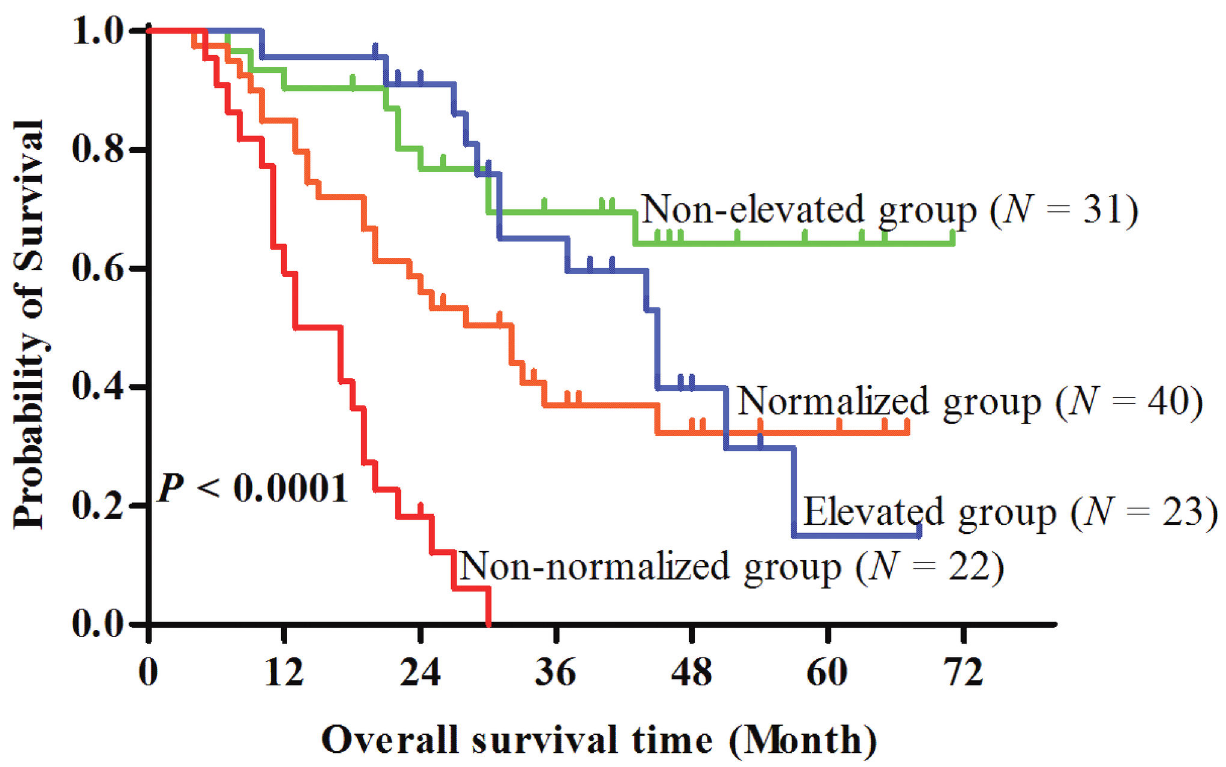
Figure 4. Kaplan-Meier analysis of the overall survival regarding CRP kinetics. Kaplan-Meier analysis of overall survival of non-elevated (CRP < 3.4 mg/L and never elevated during treatment), elevated (CRP < 3.4 mg/L and elevated at least one time during treatment), normalized (CRP ≥ 3.4 mg/L and normalized at least one time during treatment) and non-normalized (CRP ≥ 3.4 mg/L and never normalized during treatment) groups patients with metastasis nasopharyngeal carcinoma ( P < 0.0001). doi: